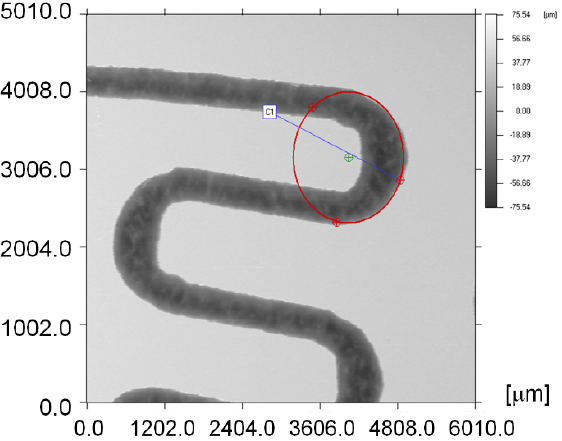
Figure 5. Measuring the curvature radius of the rectangular microchannels. Table 1. Rectangular microchannels measured curvature radii.